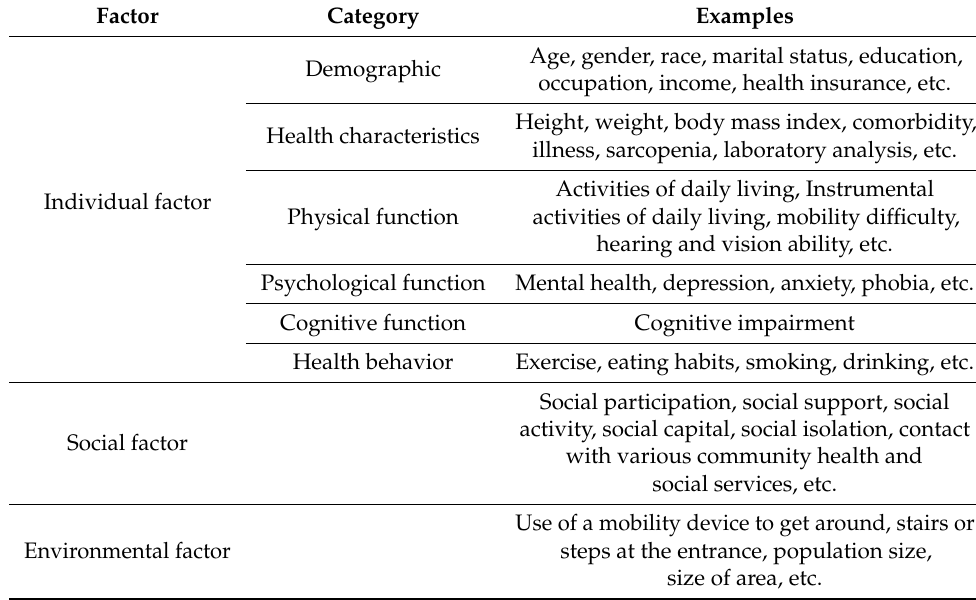
Table 1. Analysis framework of determinants of HB.